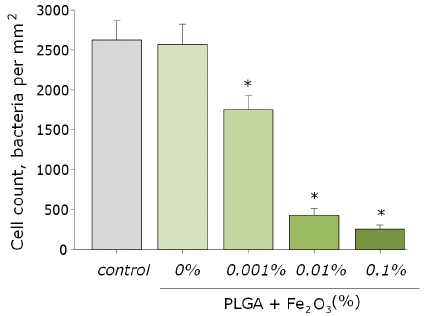
Figure 8. Influence of composite material based on PLGA and iron oxide nanoparticles on the growth and development of E. coli . *—indicates a significant difference at 5% level in comparison with the control ( p < 0.05). Data are presented as mean values and standard errors of the mean. The effect of a nanocomposite based on PLGA and iron oxide nanoparticles on the growth rate of peppers ( Capsicum annuum ) has been studied. The growth rate was determined by the leaf area. A nanocomposite rod with a diameter of 0.5 cm was stuck into the soil to the entire depth of the vessel with soil at the rate of one rod per 10 cm 2 of soil area. It was shown that neither PLGA without nanoparticles nor PLGA with iron oxide nanoparticles affected the growth rate of Capsicum annuum (Figure 9).